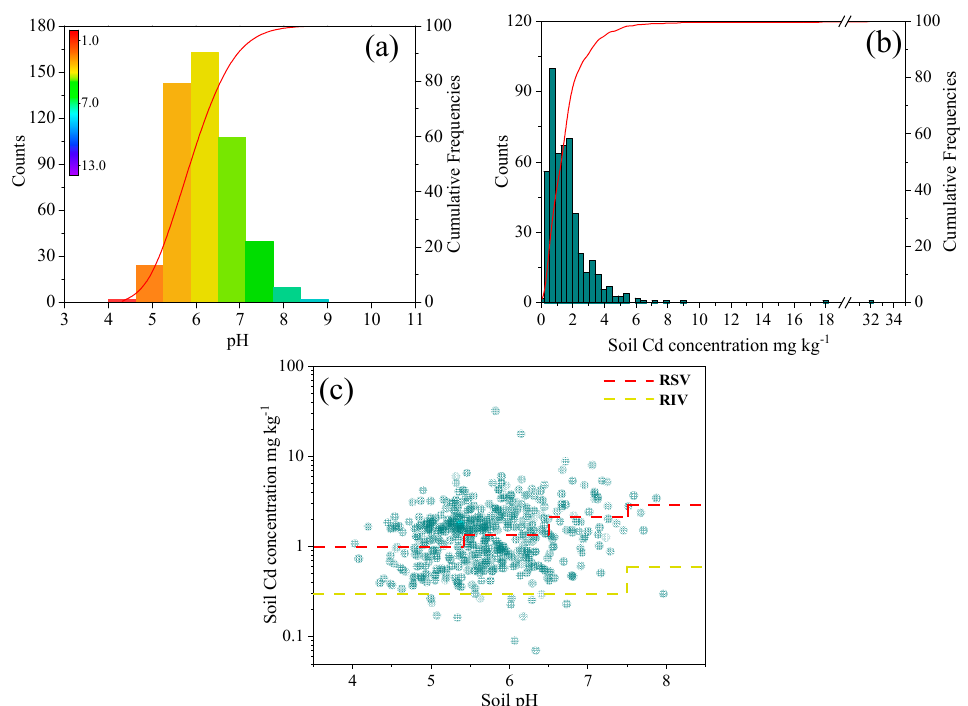
Figure 2. Cumulative frequencies of soil pH ( a ) and soil Cd concentration ( b ), scatter plots of soil pH and soil Cd concentration ( c ). RSV (yellow line in Figure 2c) represents the risk screening values for soil contamination of agricultural land in the China RIV (red line in Figure 2c) and represents risk intervention values for soil contamination of agricultural land in China.